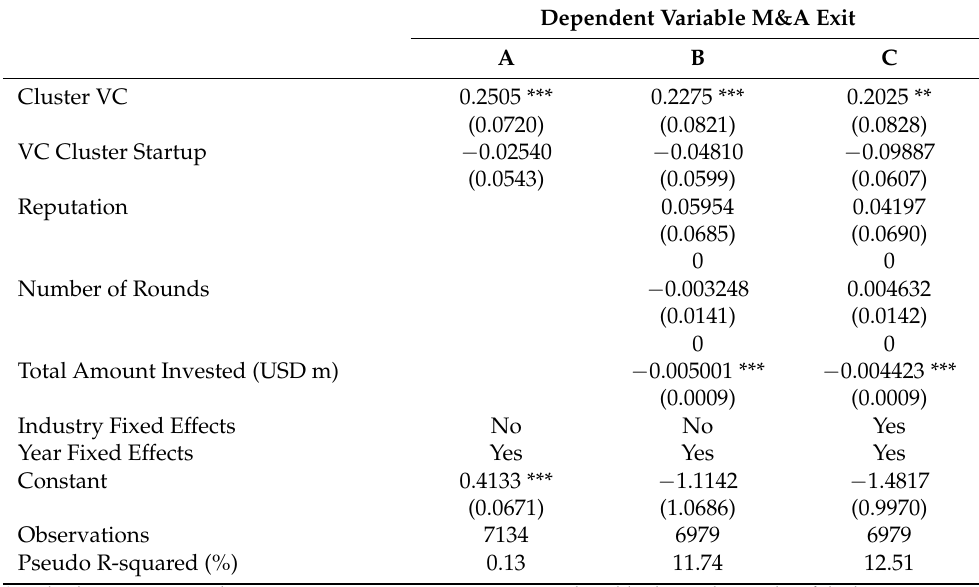
Table 5. Regression Results of Startup, Industry and VC Cluster Variables on M&A